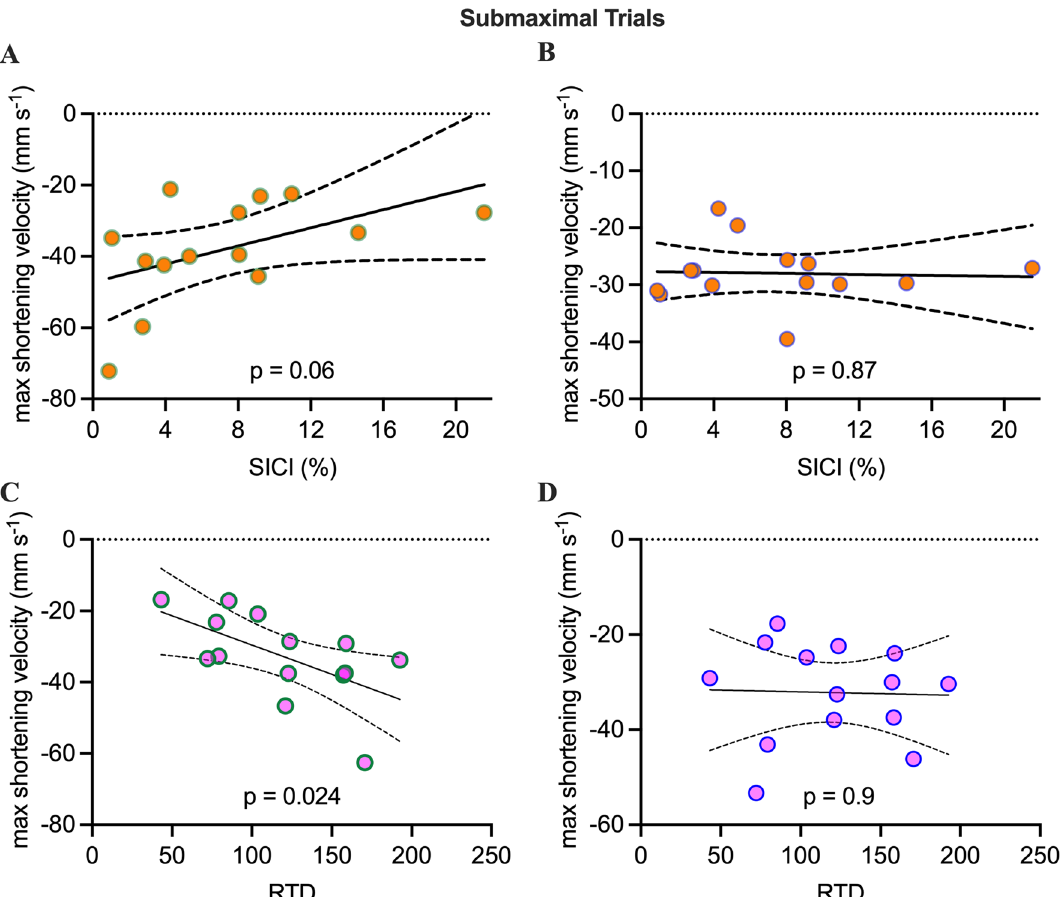
Figure 6. Correlation between the maximal shortening velocity of the TA SF and SICI ( A ) and between maximal shortening velocity of the TA SF and RTD ( C ) obtained during submaximal trials. There were no significant correlations between maximal shortening velocity of the TA DP and SICI ( B ) as well as RTD ( D ). Error bars show 95% confidence